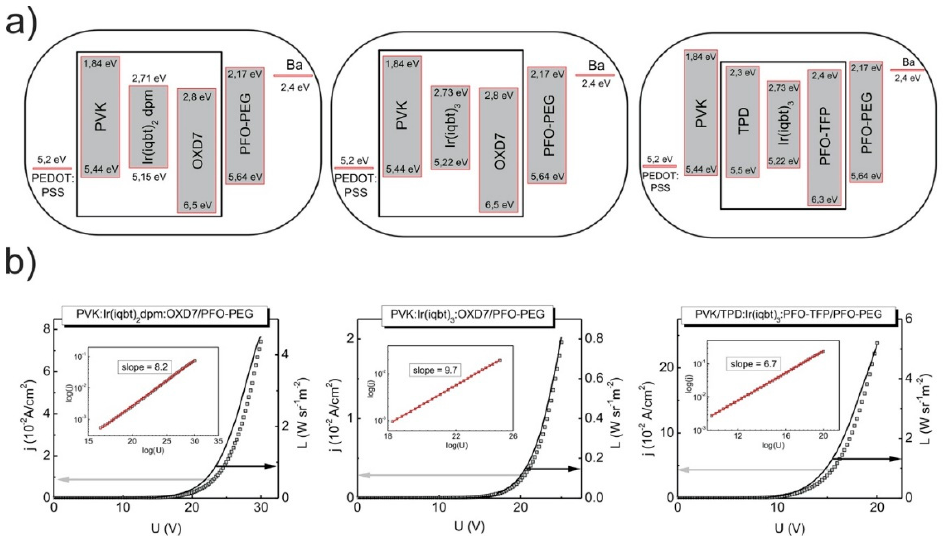
Figure 3. ( a ) The HOMO and LUMO energy diagrams of the double- and three-layer NIR OLEDs as taken from [10] and references therein, and ( b ) their current density-voltage-radiance ( j − U − L ) characteristics. Inserts: the double-logarithmic j − U characteristics with the values of the trap distribution parameter for emitting materials.